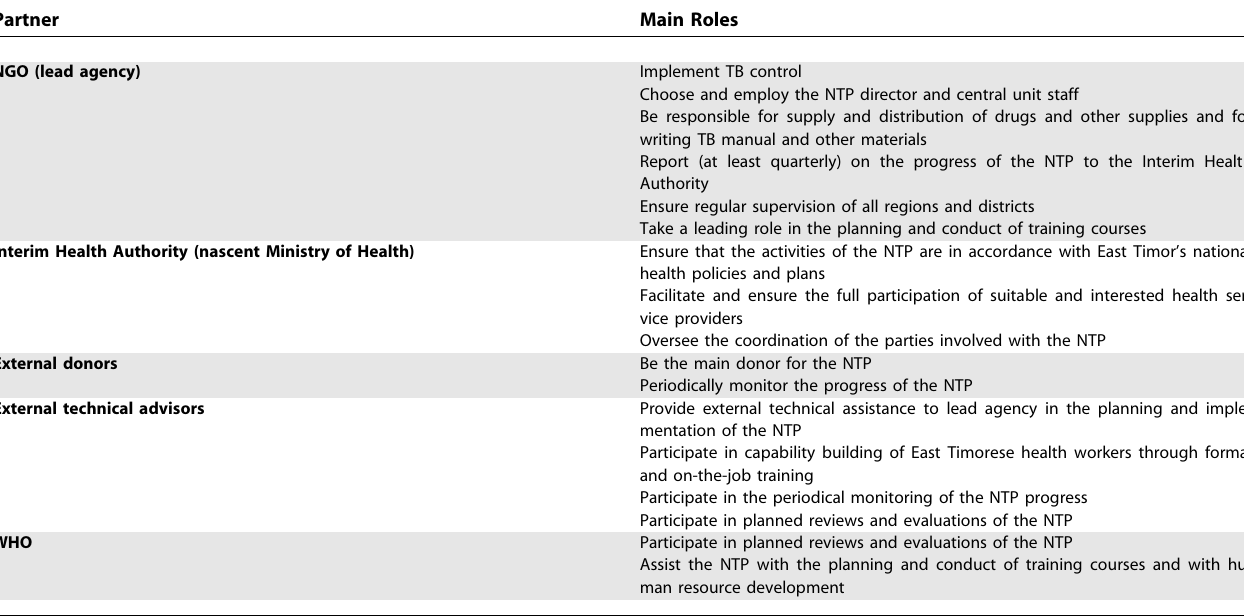
Table 3. Main Roles of Collaborating Partners in the Establishment and Implementation of the TB Program in East Timor, as Laid out in MoU in